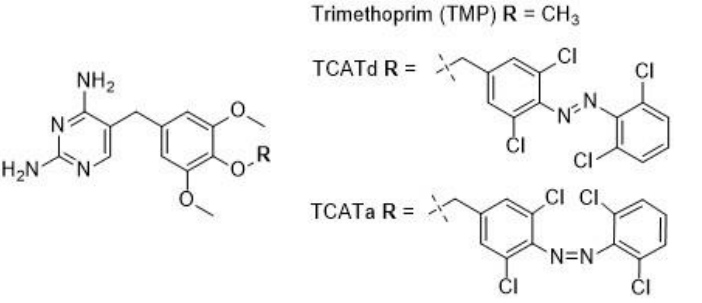
Figure 1. Structural formulas for TMP, TCATd and TCATa. The design of TCATa and TCATd is based on TMP; the difference in rest group ( R ) for each compound is shown in detail.